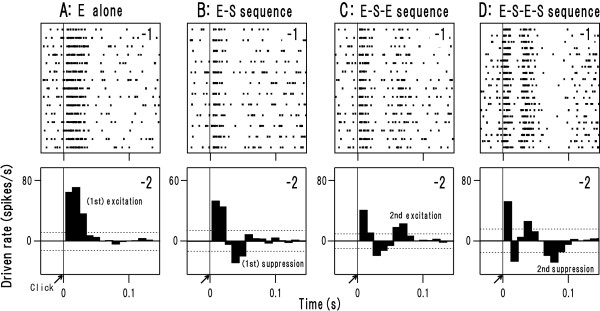
Dynamics of firing responses of 4 representative neurons (A: non-synchronization type; B-D: synchronization type) in the single-click paradigm. A single click (arrow) was presented, and the spike occurrence was examined with raster dot plots (-1) and post-latency time histogram (bin width = 10 ms; -2). The threshold for excitation and suppression was set at plus/minus 2*SD of the mean of spontaneous firing rate (dotted line), respectively. The qualitatively distinct responses were aligned in the following sequence: only excitation (A), excitation (E) followed by suppression (S) (hereafter, "E-S sequence"; B), "E-S-E sequence" (C) and "E-S-E-S sequence" (D).